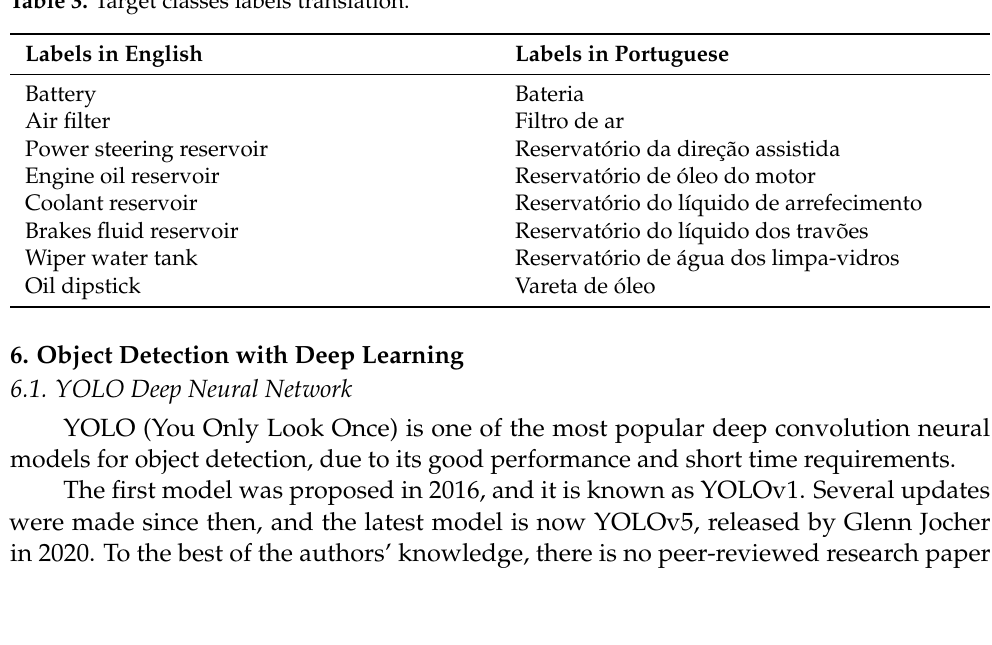
Table 3. Target classes labels